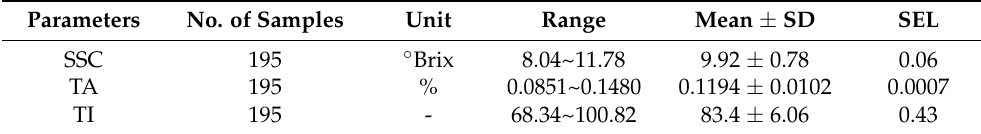
Table 1. Statistical results of lignin content in snow pears.